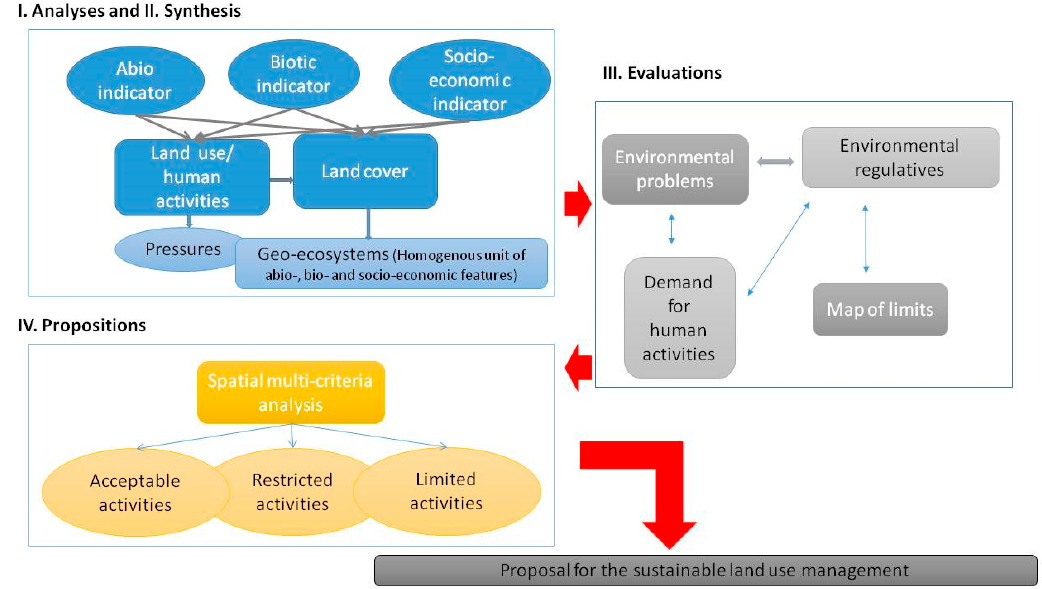
Figure 2. Methodological approach for sustainable land use management.